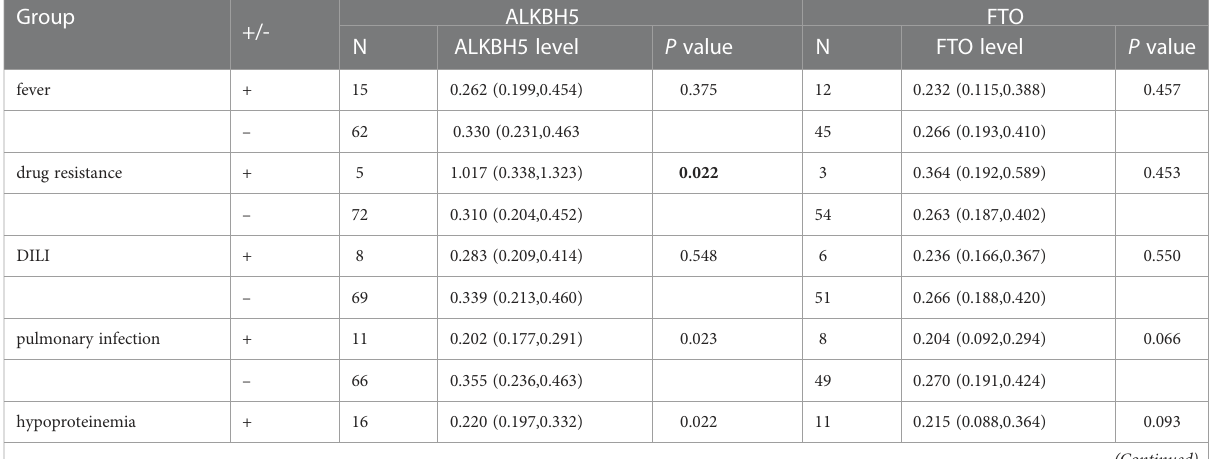
TABLE 3 The association between ALKBH5, FTO levels and clinical manifestations in PTB patients.